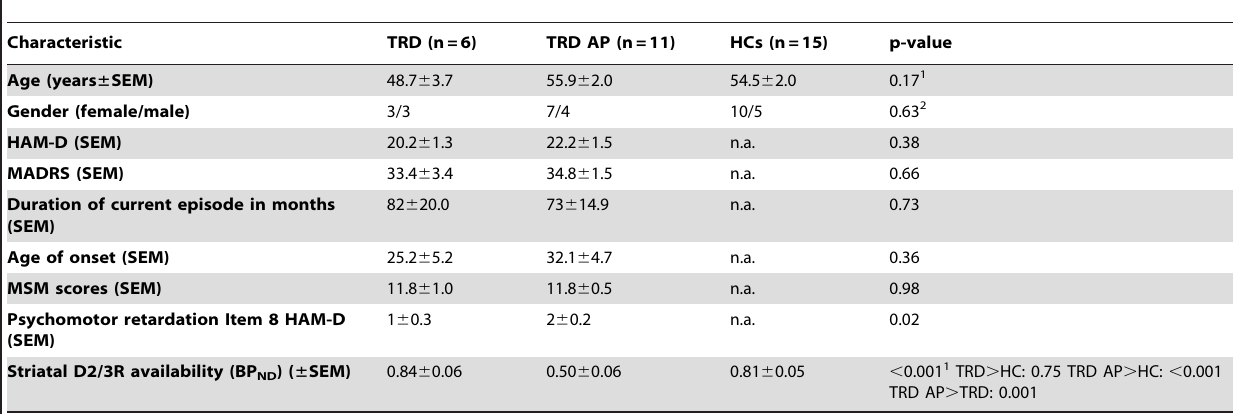
Abbreviations: TRD; Treatment resistant depression, TRD AP; Treatment resistant depression patients using antipsychotics, HCs; Healthy Controls, SEM; standard error of the mean MADRS; Montgomery Asberg Depression Rating Scale, HAM-D; Hamilton Depression Rating Scale, MSM; Maudsley Staging Method, BP ND ; Binding Potential non-displaceable (reflects striatal D2/3R availability) 1 One way ANOVA.